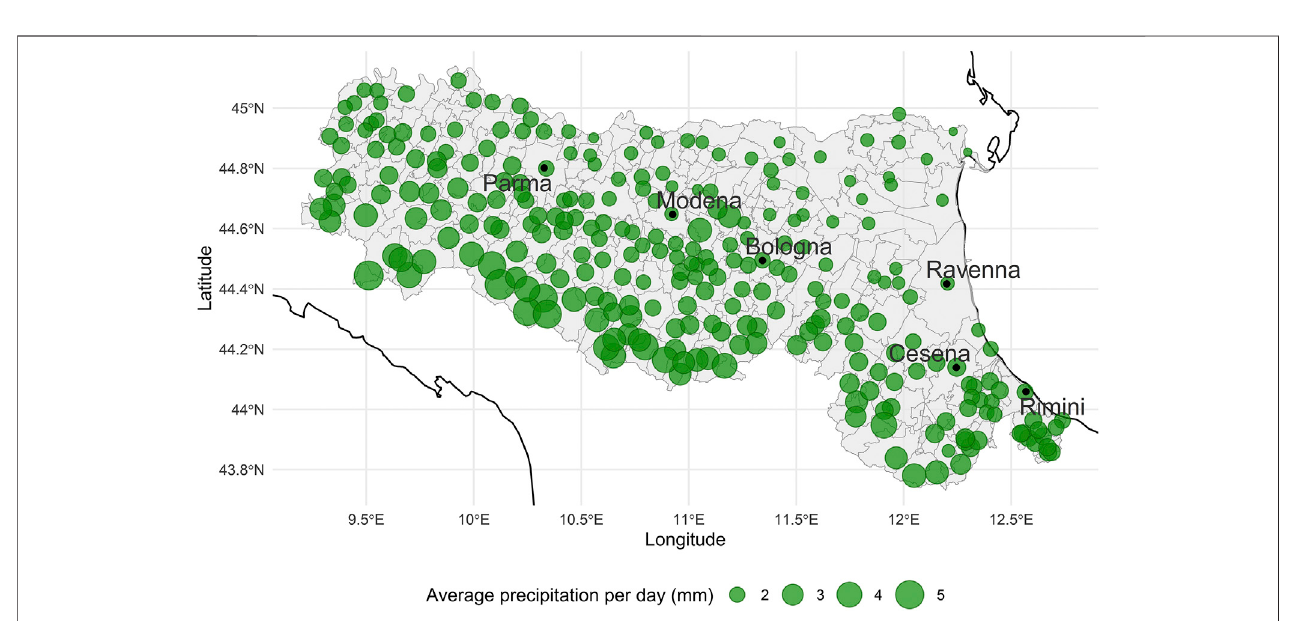
FIGURE 3 | Geographical distribution of daily rainfall average (mm) in 1981 – 2018. Municipality boundaries are shown in black.